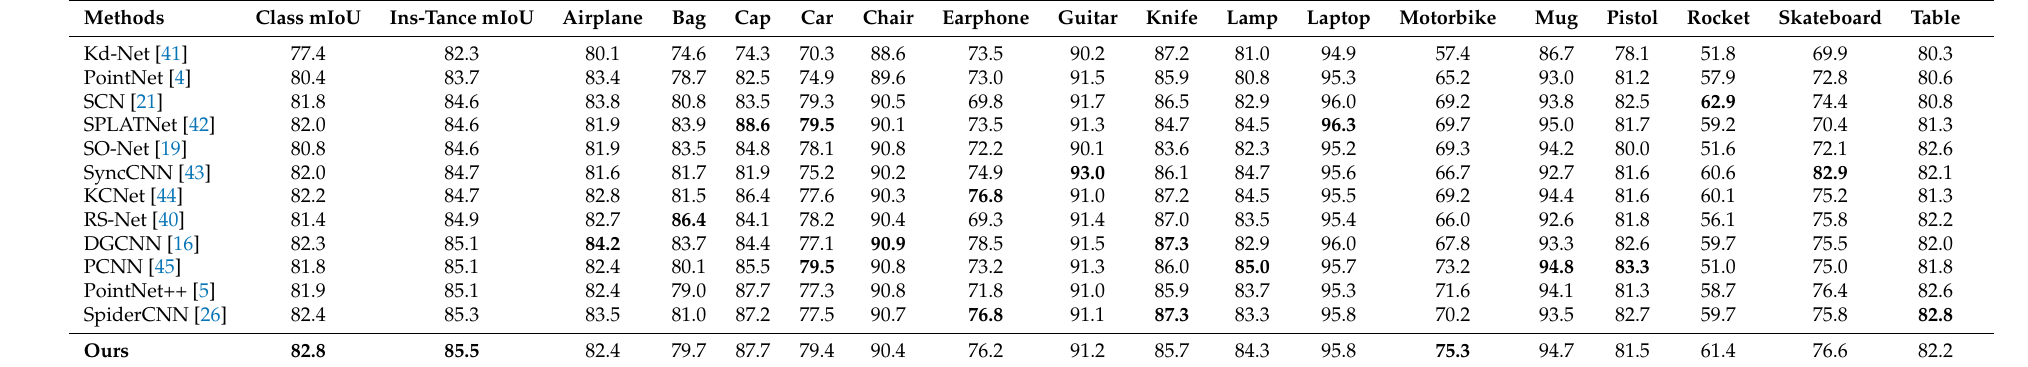
Table 3. Shape part segmentation results on ShapeNet-Part benchmark. The bolded text indicates the best